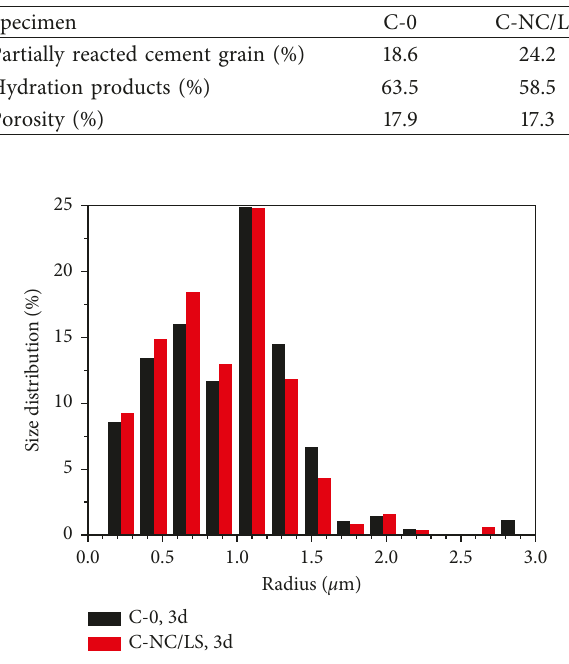
Figure 9: Pore size distributions of Figure 7, cement pastes and mortar containing NC/LS